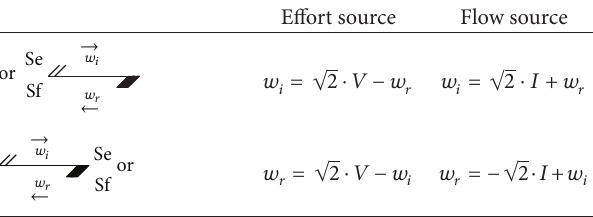
Table 1: Scattering source